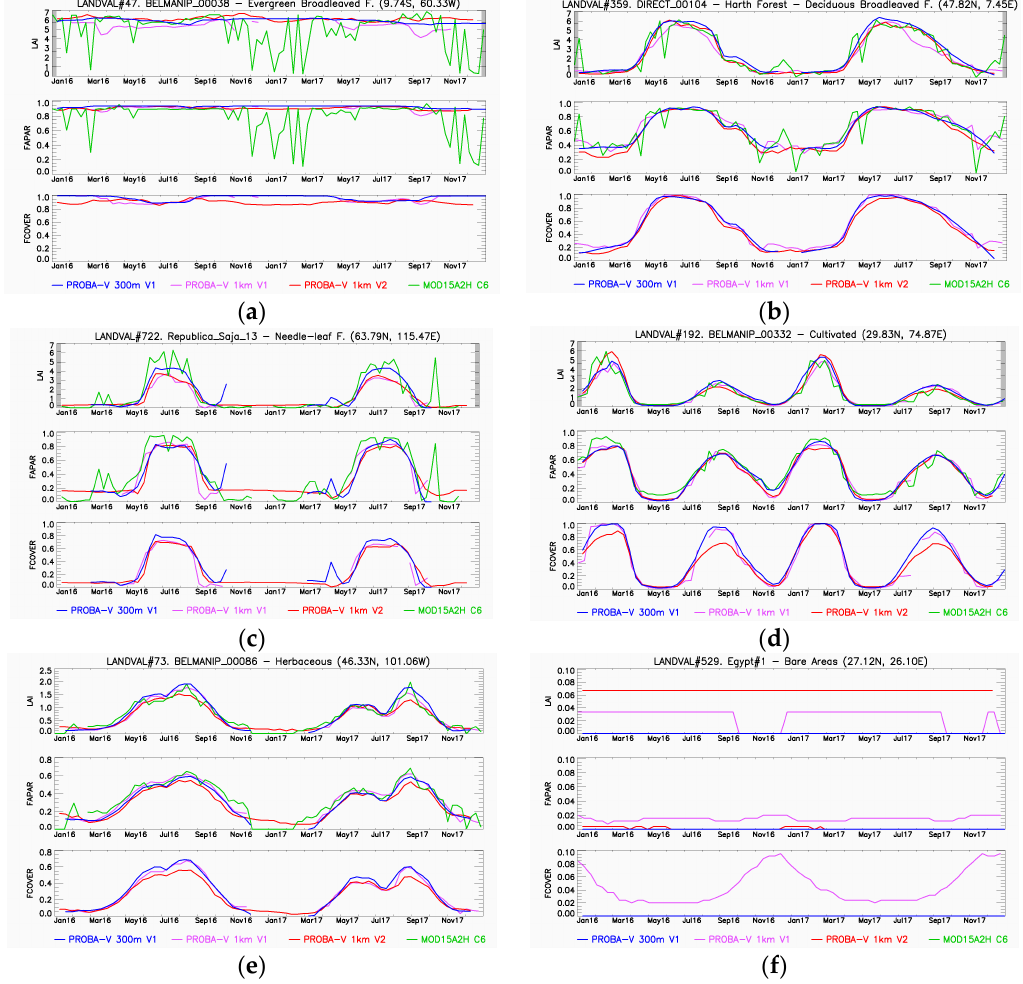
Figure 3. Example of temporal profiles (Jan 16–Dec 17) of PROBA ‐ V Collection 300 m V1 and reference products (PROBA ‐ V Collection 1 km V1, PROBA ‐ V Collection 1 km V2 and MODIS15A2 C6) for sites corresponding to evergreen broadleaved forest ( a ), deciduous broadleaved forest ( b ), needle ‐ leaf forest ( c ), cultivated ( d ), herbaceous ( e ) and bare areas ( f ).